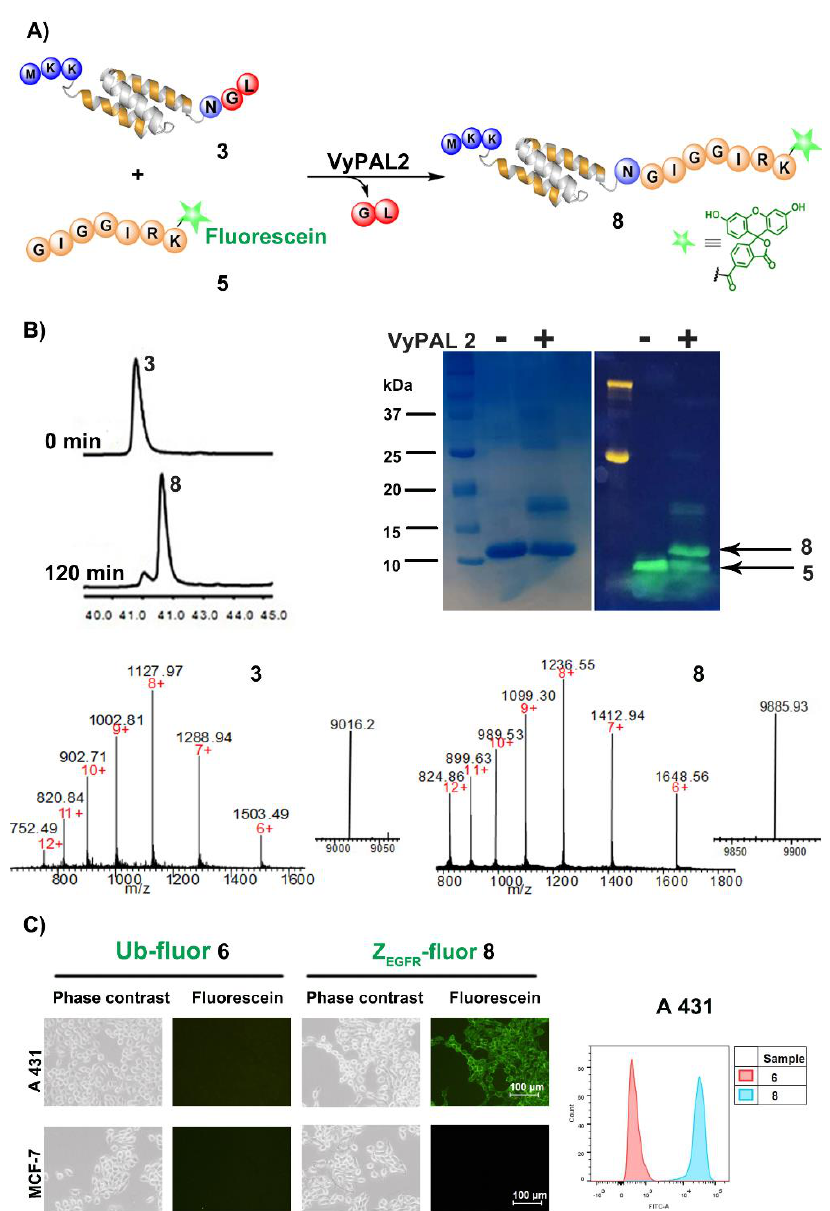
Figure 2. C-terminal labeling of Z EGFR 3 by fluorescent peptide 5 for cell binding analysis. ( A ) The labelling reaction scheme. ( B ) Monitoring of the reaction by HPLC and SDS gel (upper panel; note: the band corresponding to peptide 5 on the Coomassie gel image was washed away by the destaining solution during the destaining step), and ESI-MS analysis of the labelling product (lower panel; 3 : Calcd. 9014.1, Obsvd. 9016.2; 8 : Calcd. 9883.5, Obsvd. 9885.9). ( C ) Fluorescent microscopy imaging and flow cytometry analysis. Fluorescence-labeled affibody 8 and ubiquitin 6 (Figure S2) were used to treat cancer cell lines MCF-7 (EGFR-low expressing) and A431 (EGFR-overexpressing), and the treated cells were subjected to flow cytometry analysis and fluorescent microscopy. As shown in ( C